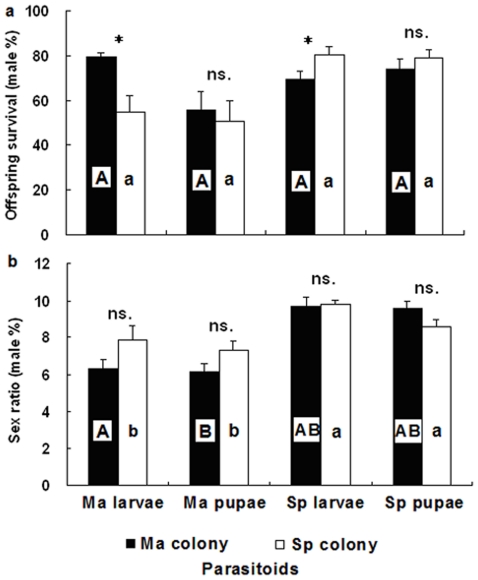
Offspring survival and sex ratio of Sclerodermus harmandi from different culturing systems on two host species and stages: (4a) offspring survival, (4b) sex ratio (proportion of males).Same alphabets on columns indicate no significant differences (P<0.05). For abbreviations see Figure 1 (Mean±SE, n = 20–24 females in each treatment, * P<0.05 and ns. P>0.05).